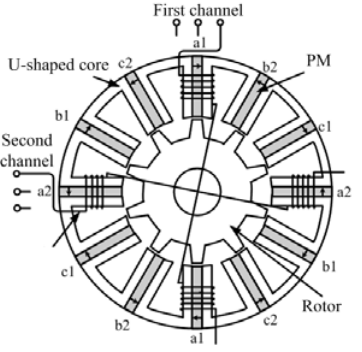
Figure 11. FSPM redundant structure.